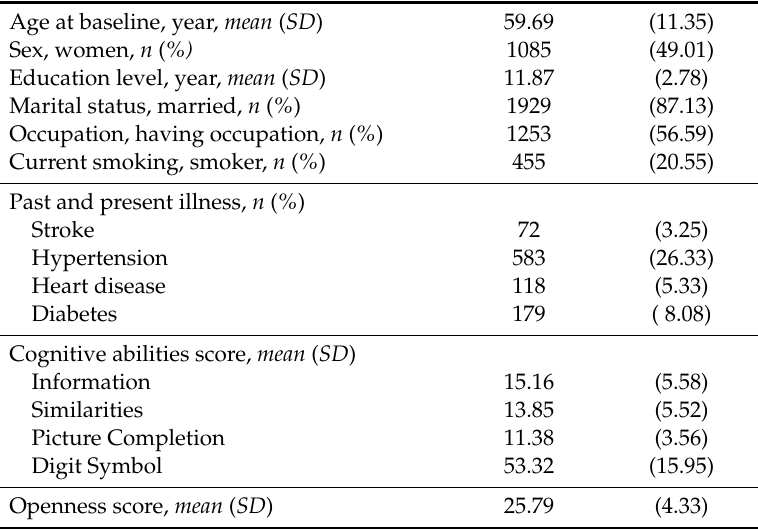
Table 2. Participant characteristics at baseline.